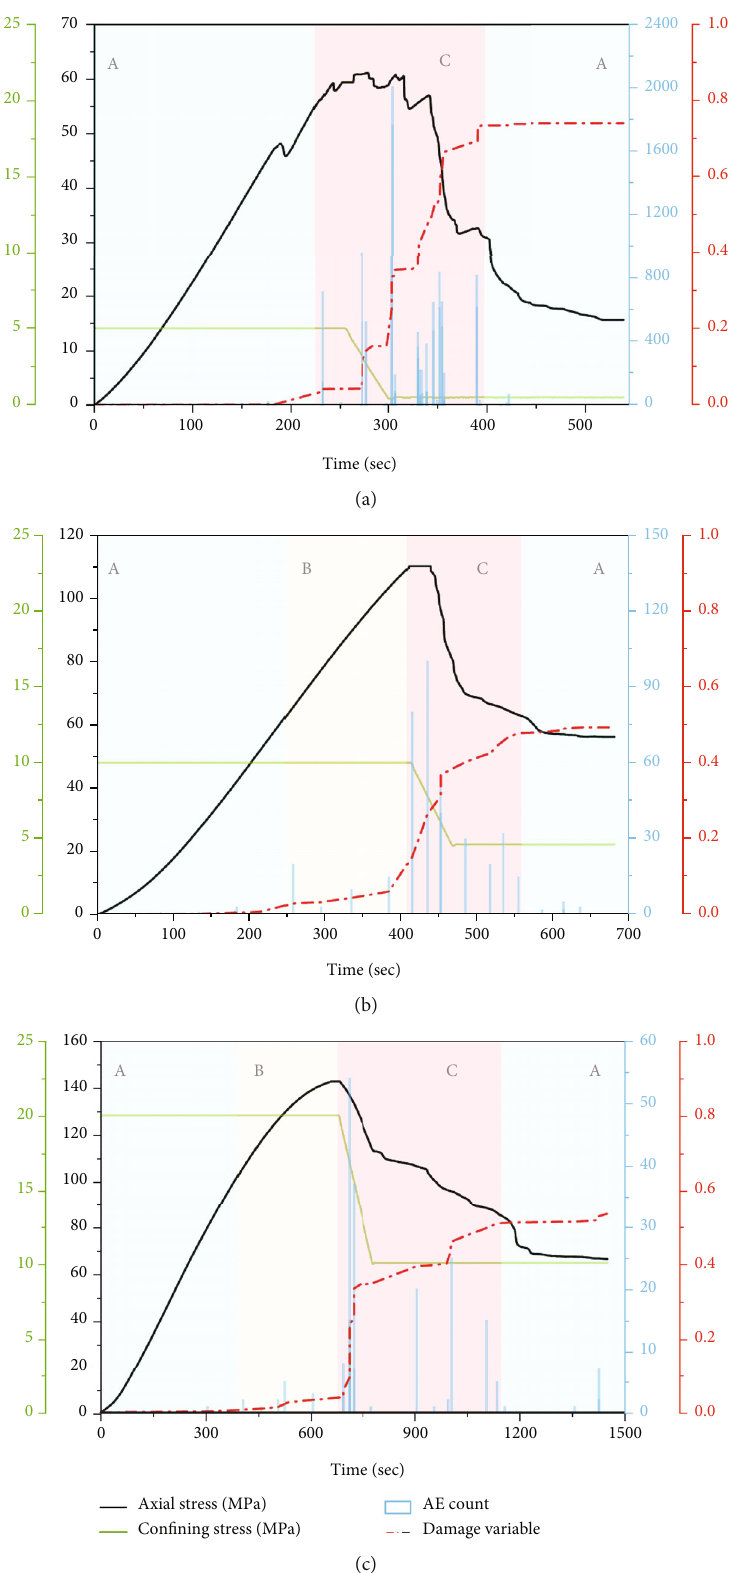
Figure 9: AE ringing count/damage variable-time relations of Scheme 2 under di ff erent con fi ning pressures (con fi ning pressure setting: (a) 5MPa, (b) 10MPa, and (c)